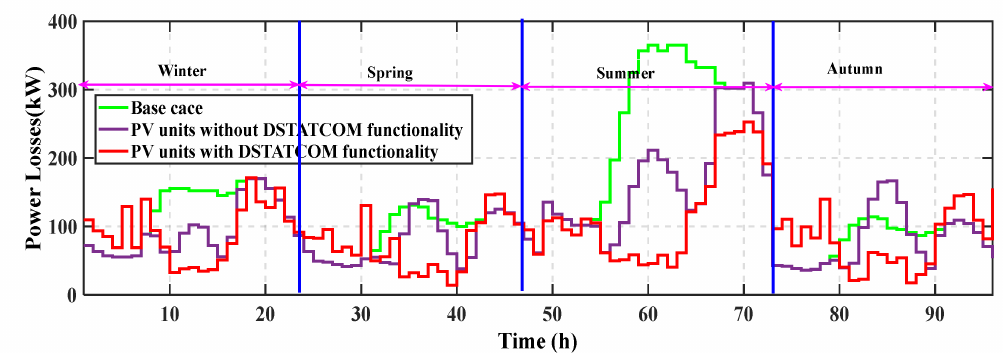
Figure 12. The power losses of four